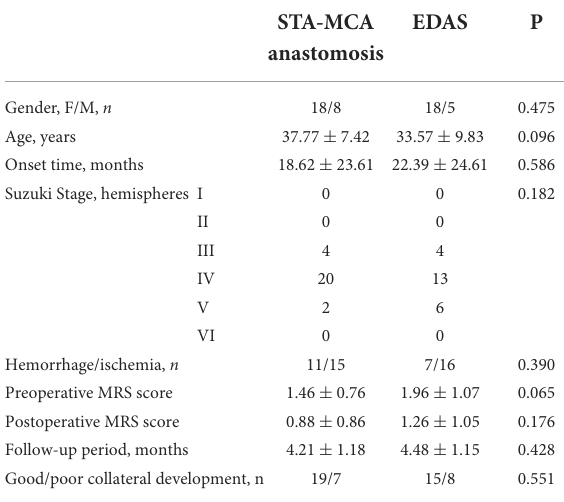
TABLE 1 The demographic and clinical characteristics of the MMD